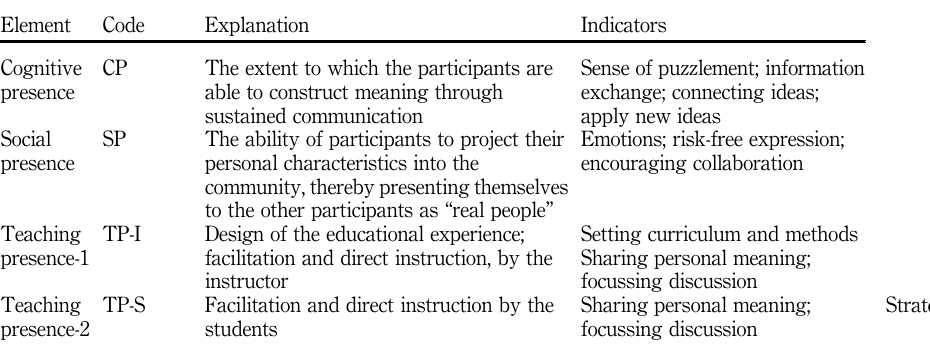
Table III. Strategy adopted